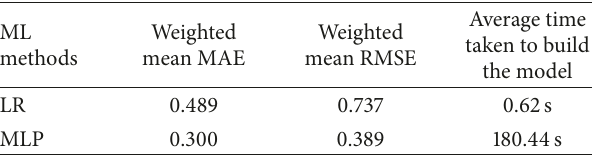
Table 3: Weighted mean values of the experimental results for the data divided into Mini-AWSs.